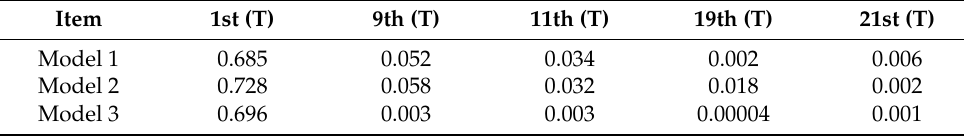
Figure 9. Open − circuit flux density harmonics of the three models. Table 4. The amplitude of open − circuit flux density harmonics in the three models.